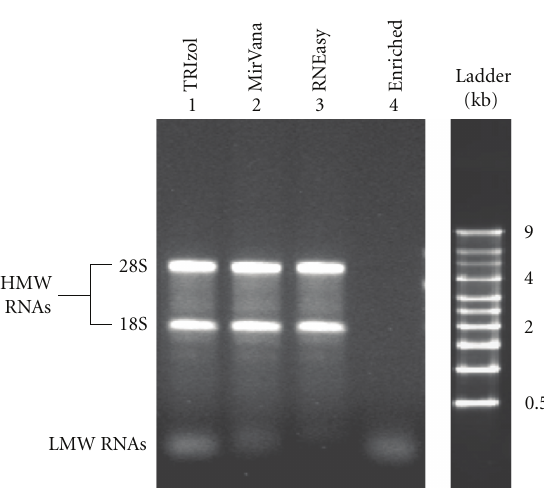
Figure 1: Gel electrophoresis (agarose 1% stained with ethidium bromide) of RNA samples (from COS-1) extracted with TRIzol reagent (lane 1), MirVana kit (lane 2), RNEasy kit (lane 3), and LMW RNA fraction enriched with MirVana kit (lane 4).